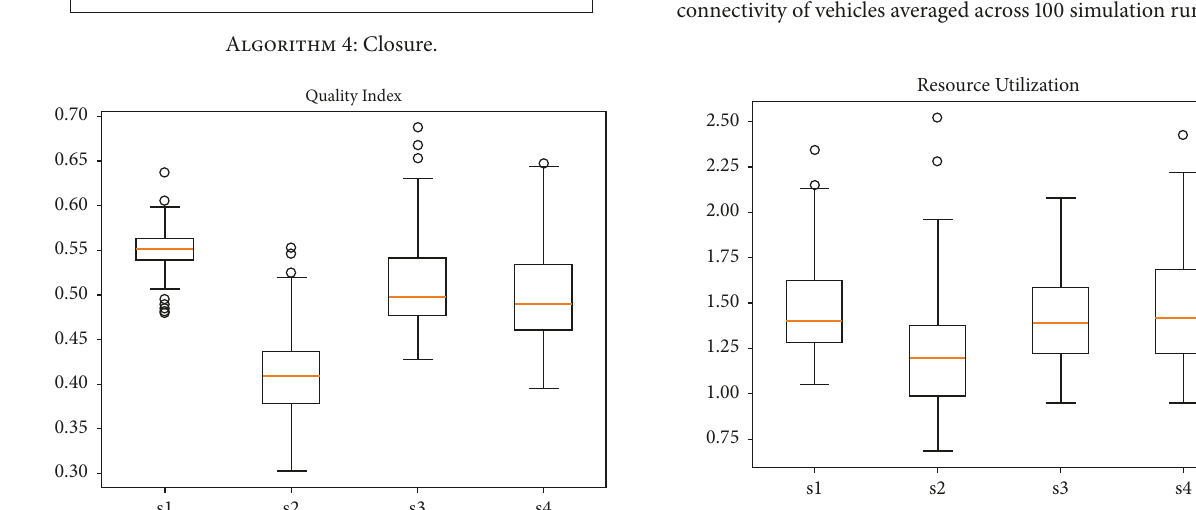
Figure 4: Comparison of strategies ( 𝑡ℎ 𝑠𝑡𝑟𝑜𝑛𝑔−𝑡𝑖𝑒 = 5 ): average quality of resources experienced by vehicles averaged across 100 simulation runs.